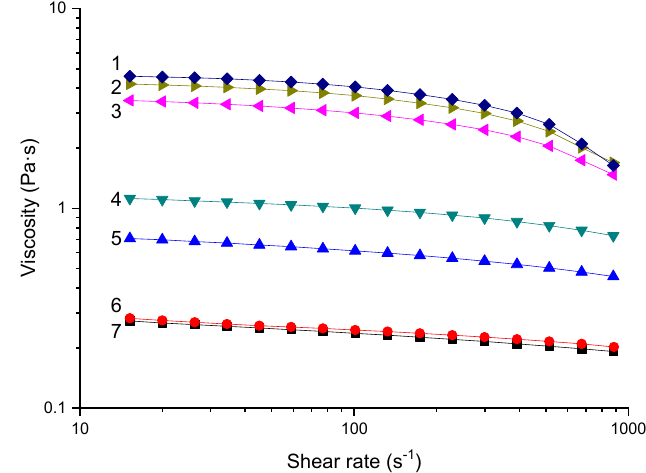
Figure 1. Viscosity-shear rate curves for 5 wt% solutes in 65 wt% ZnCl 2 solution at 55 °C. Curve 1–7 represent different cellulose contents of 100 wt% (pure cellulose), 90 wt%, 70 wt%, 50 wt%, 30 wt%, 10 wt%, and 0 wt% (pure starch).